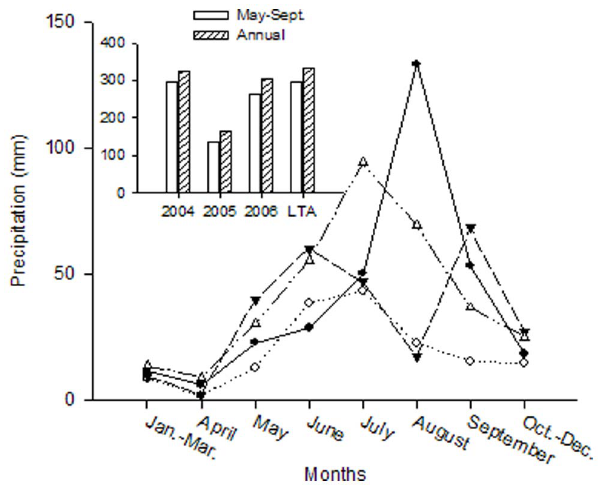
Figure 1. Precipitation (mm) of the experimental site. A solid line (seasonal precipitation in 2004), a dotted line (seasonal precipitation in 2005), a long dashed line (seasonal precipitation in 2006) and a dash- dot-dot line (seasonal long-term average precipitation from 1982 to 2006). The inserted figure showed annual precipitation in 2004, 2005, 2006 and annual long-term average precipitation (LTA) from 1982 to 2006.